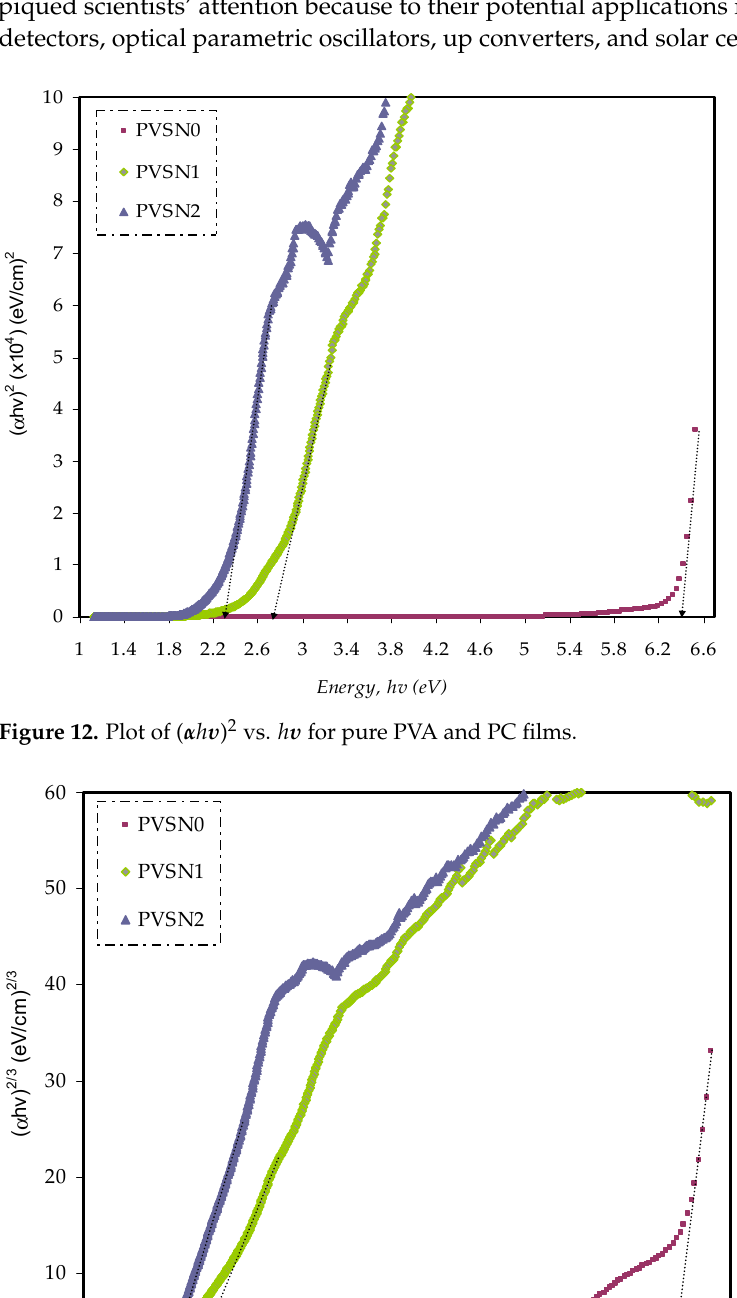
Figure 14. Plot of ( α h υ ) 1/2 vs. h υ for pure PVA and PC films.